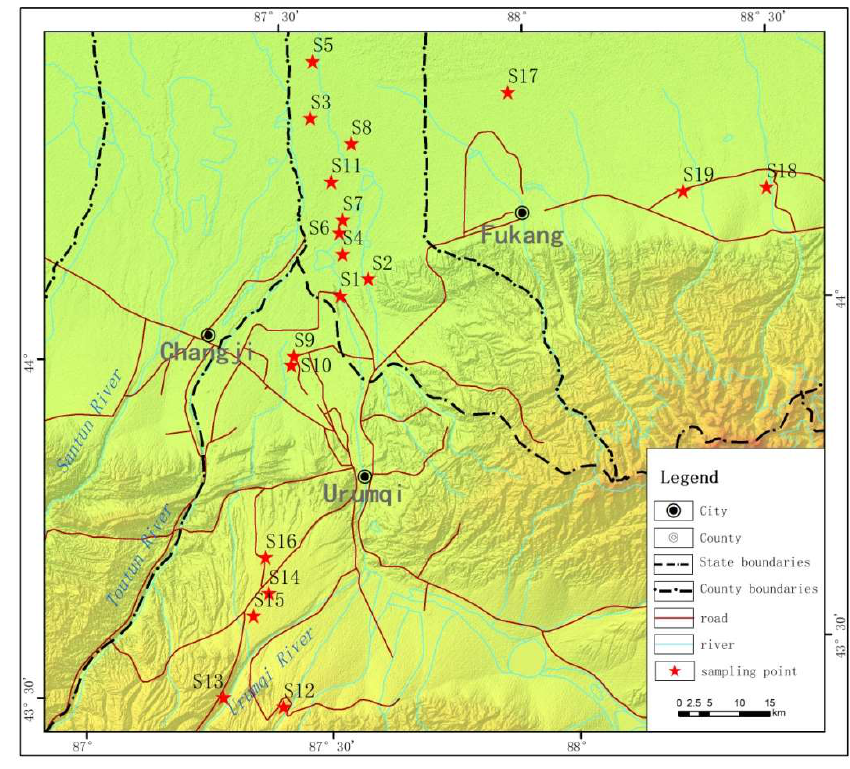
Figure 1. The Map of the sampling points. Table 1. Characteristics of the sampling points.